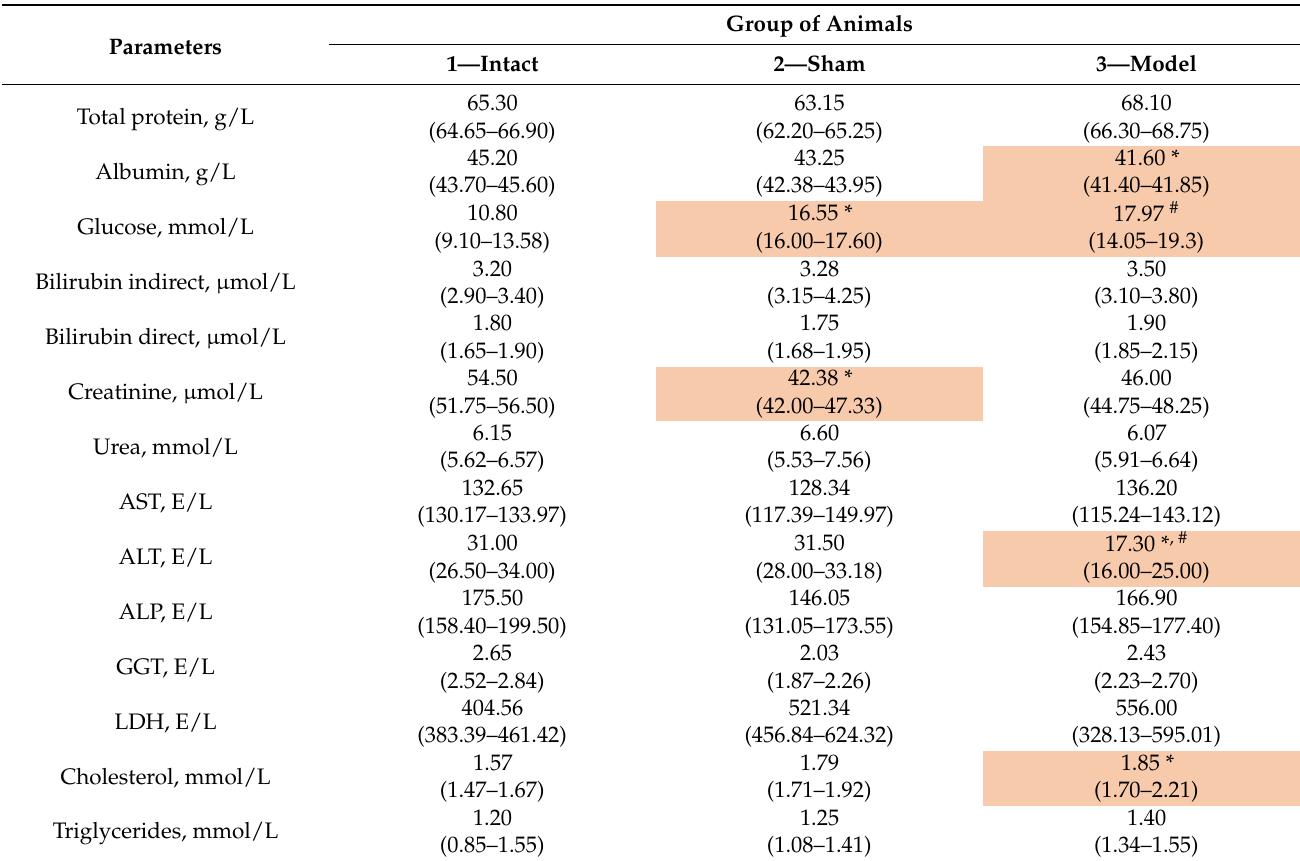
Table 6. Results of animal blood serum biochemical analysis at the end of the experiment. The results are presented as Me, (P 25 –P 75 ). In the table, colored cells allow to focus on the most important